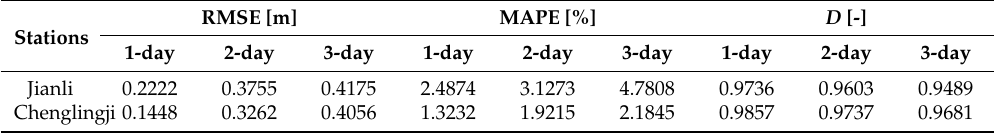
Table 4. Computations of RMSE, MAPE and d for different forecast lead time (LSSVM i ).